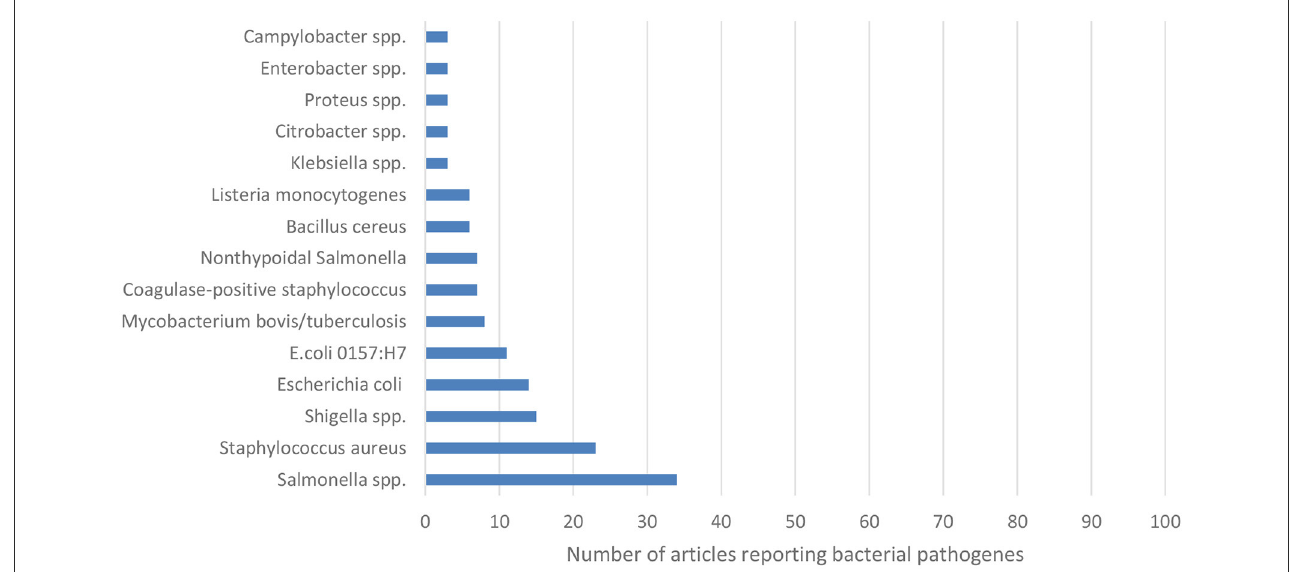
FIGURE4 Number of articles reporting a particular bacterial pathogen. Numbers are derived from every article investigating on the pathogens. That is an article may report more than one bacteria species.